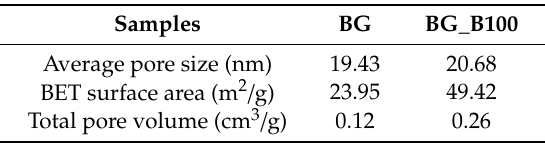
Table 2. Average pore size Brunauer–Emmett–Teller (BET) surface area and total pore volume of BG and B-doped BG.